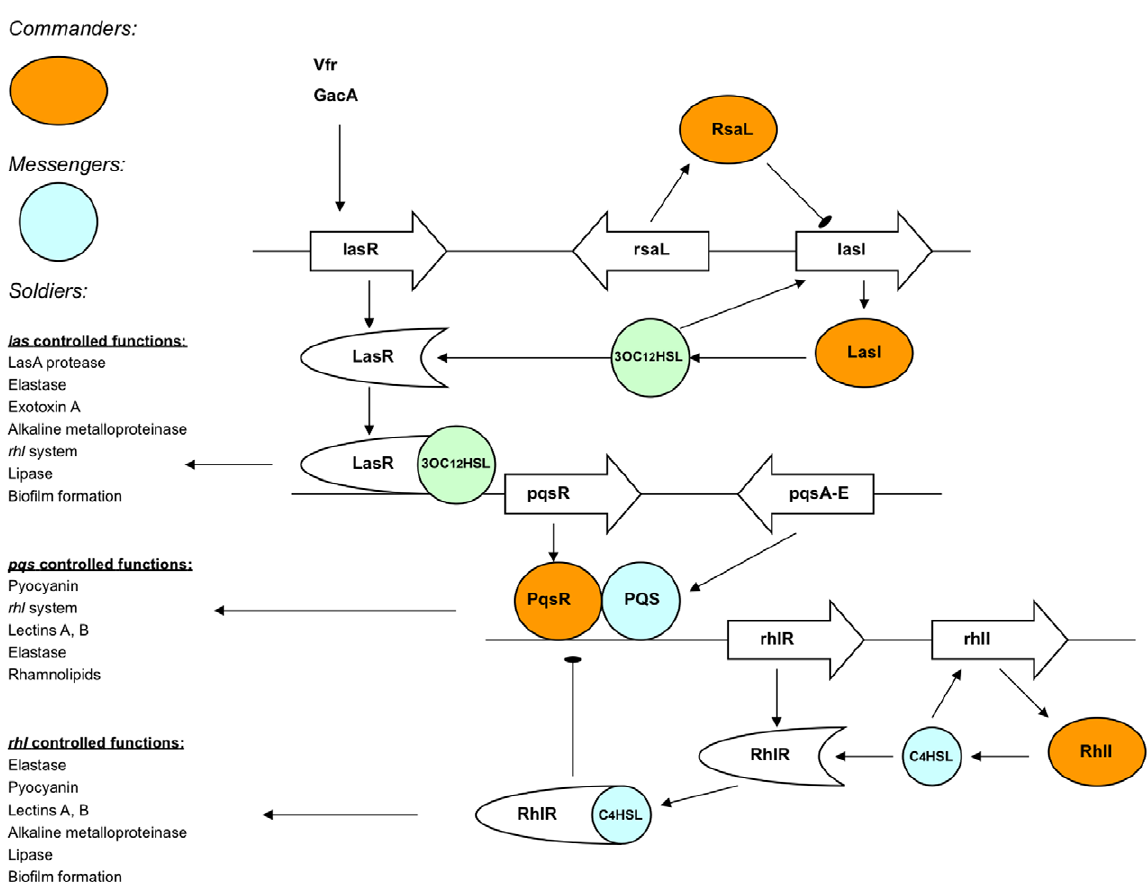
Figure 1. Schematic overview of the complex QS systems present in P.aeruginosa . The commanders represent the major regulatory systems, while the messengers are the signaling molecules. The soldiers represent the various virulence factors that have a function in the interaction of P. aeruginosa with the host.